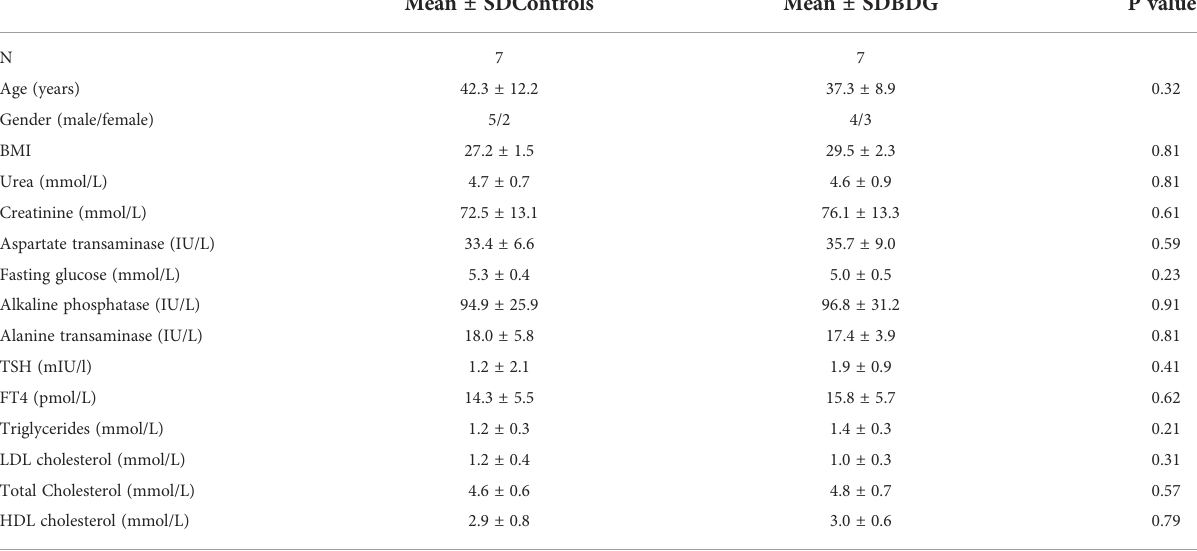
TABLE 1 Mean, SD and P values of biochemical characteristics of study